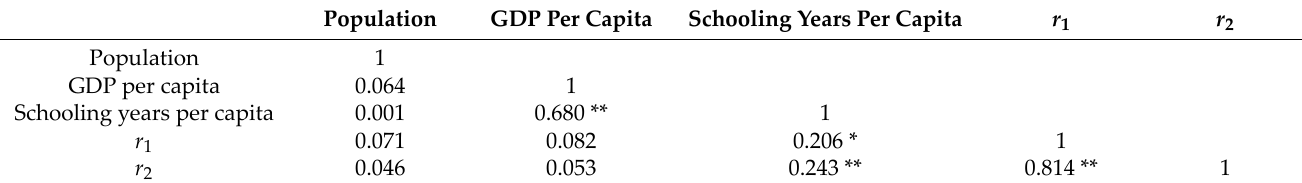
Table 5. Correlation between correlation coefficients of between PM 2.5 concentrations and APR or HR weibos and socioeconomic factors in 2017–2020 1